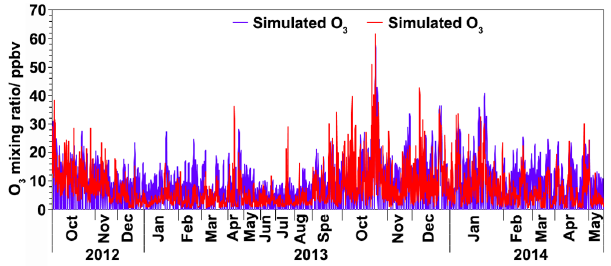
Figure 7. Hourly simulated and observed O 3 during daytime hours (07:00–19:00LT) at